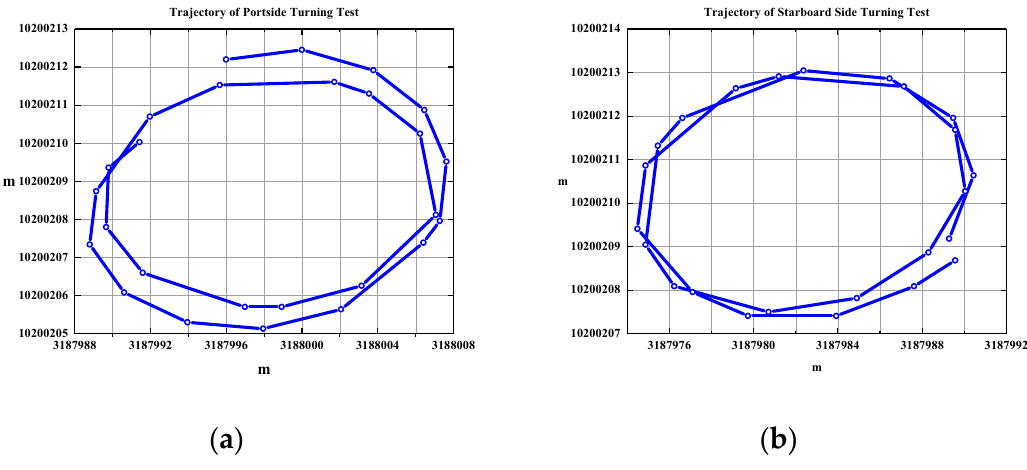
Figure 7. Path of turning test ( a : port; b : starboard).